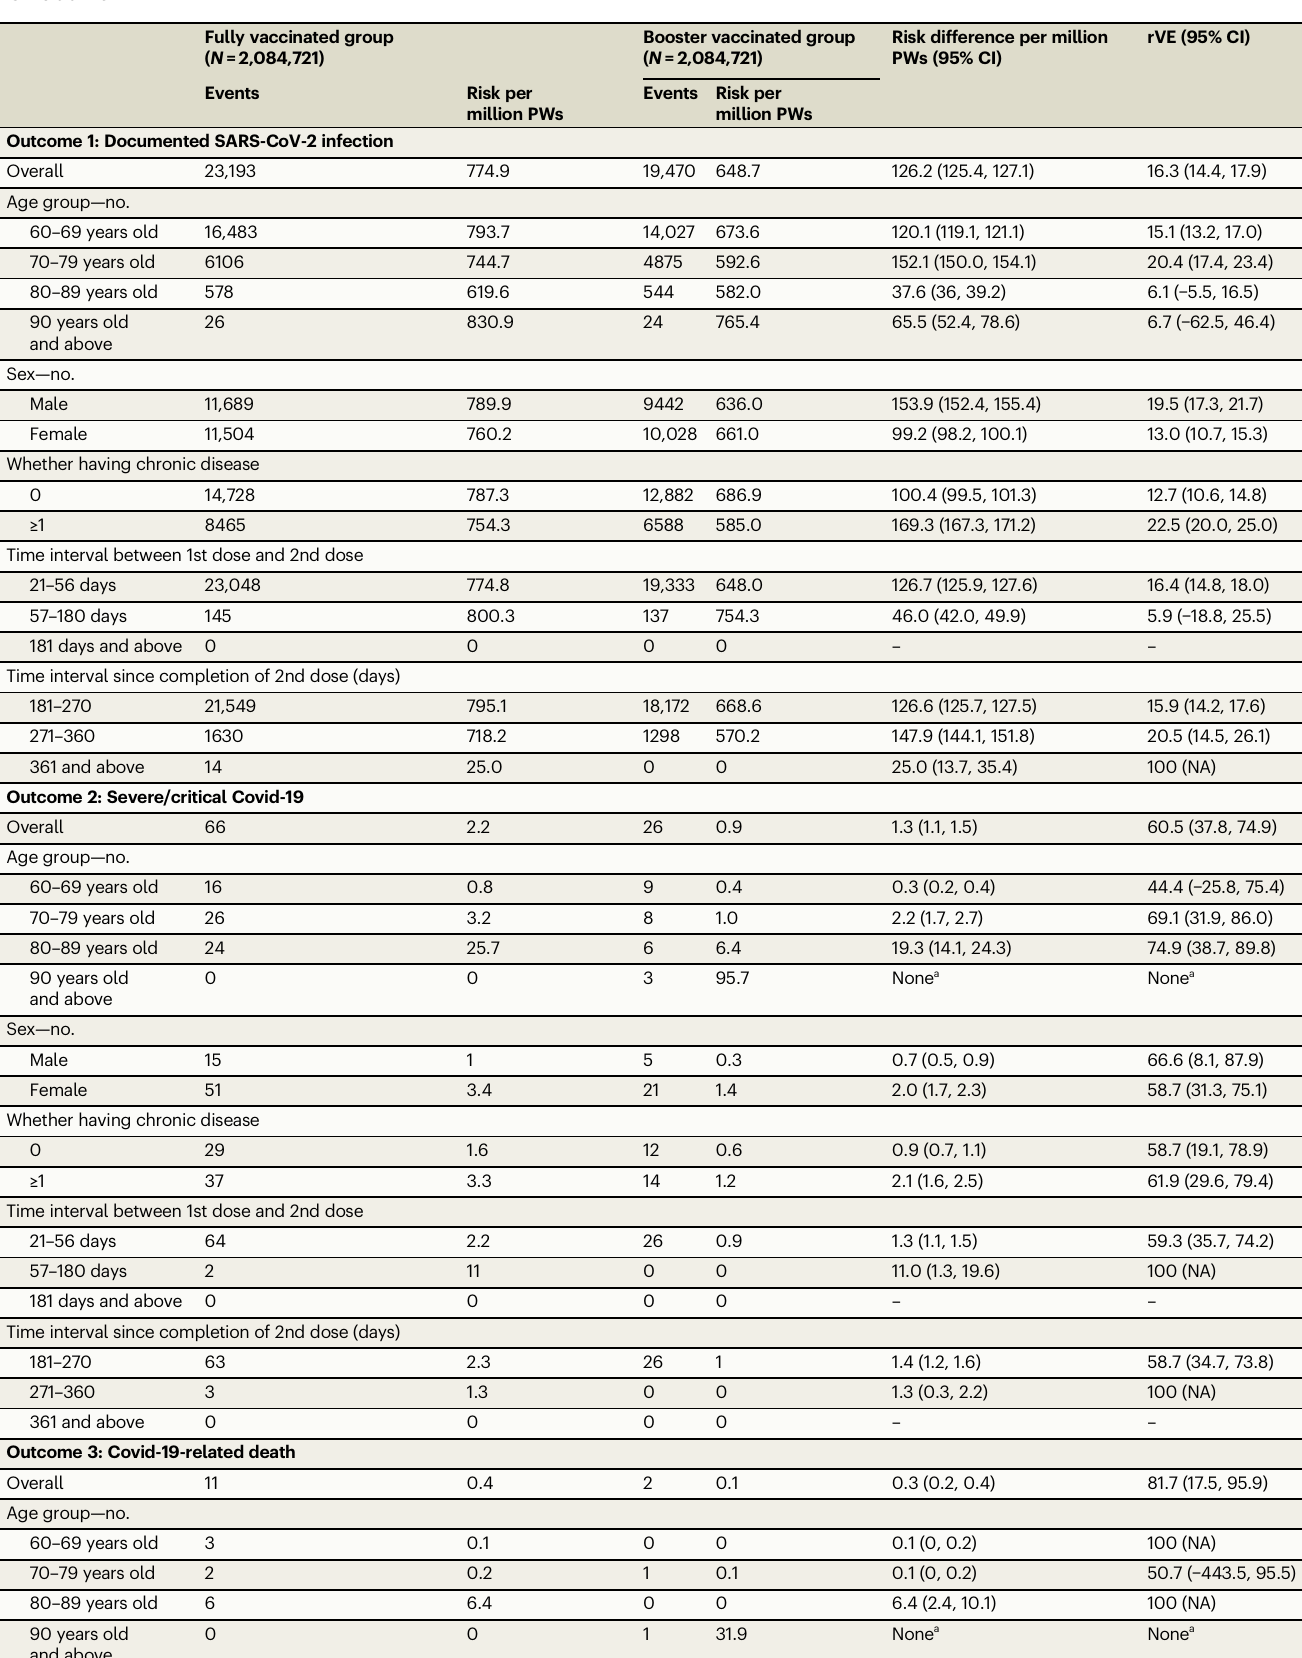
Table 4 | Adjusted relative vaccine effectiveness of the booster vaccination comparing to full vaccination of inactivated Covid- 19 vaccine Fully vaccinated group ( N